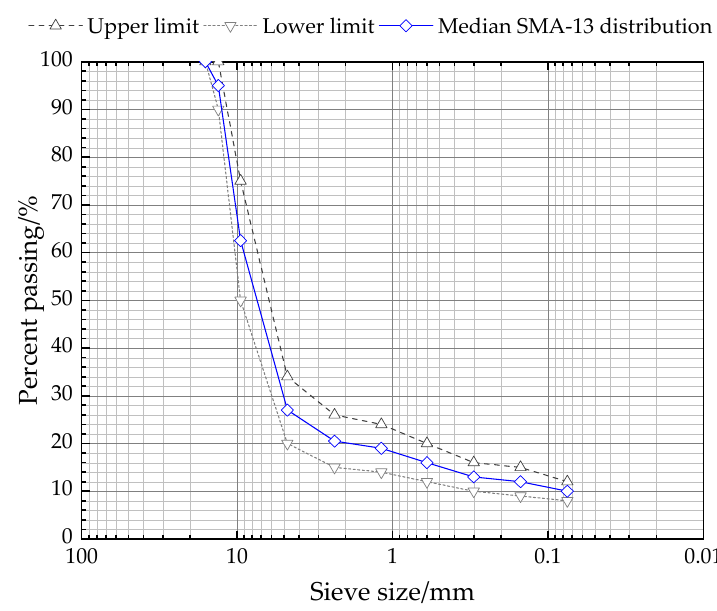
Figure 2. Gradation of stone mastic asphalt (SMA)-13.